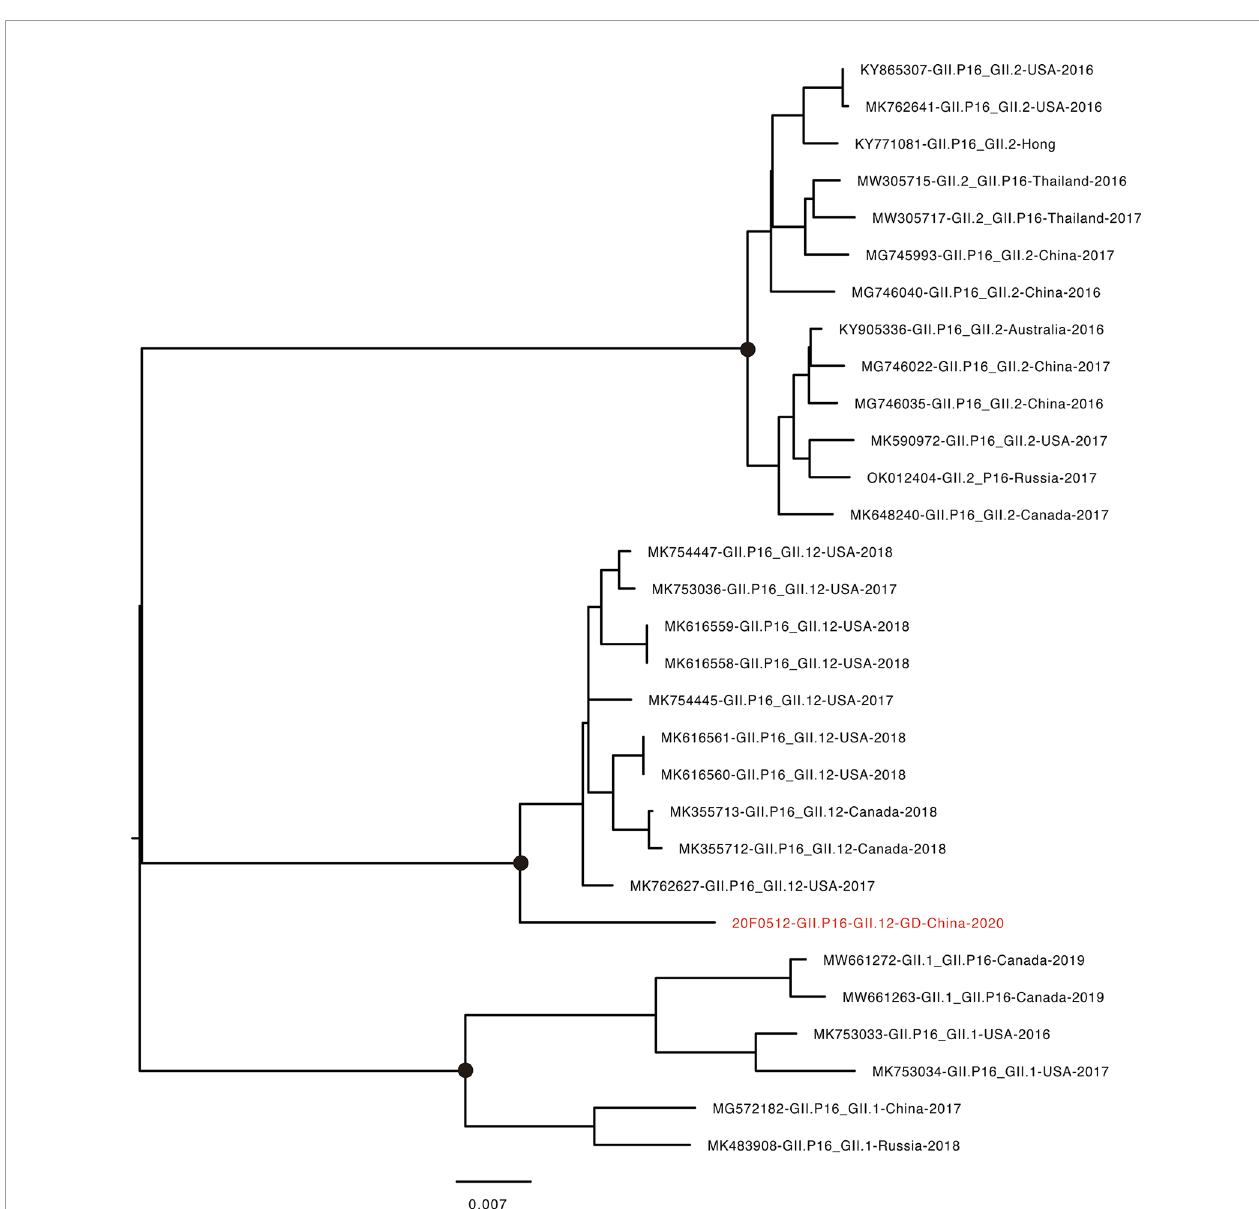
FIGURE 3 | Phylogenetic tree of whole-genome for NoV GII.12[P16]. The sequence highlighted in red indicates the GII.12[P16] strain found in the current epidemic. GenBank accession numbers, genotype, the country identi fi ed, and year identi fi ed are provided. Scale bar represents the number of differences between sequences. Black dots indicate bootstrap support >80 at the root node of selected